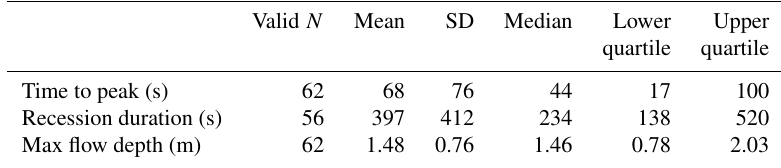
Table 5. Basic statistics on debris-flow surges duration and flow